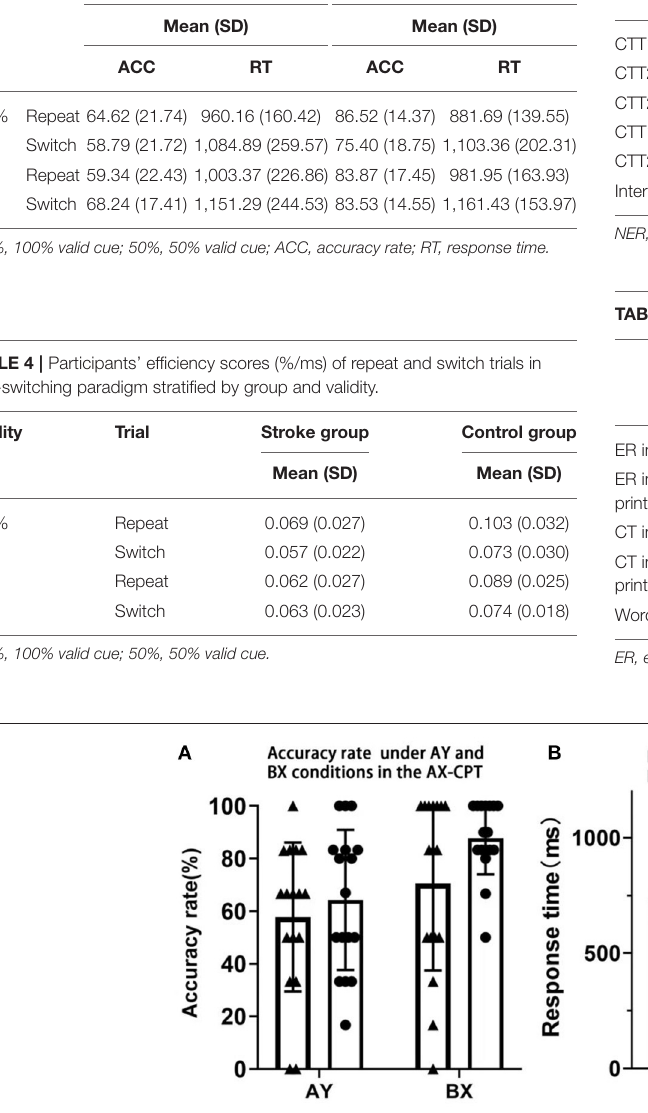
TABLE 3 | Participants’ accuracy rates (%) and response times (ms) of repeat and switch trials in task-switching paradigm stratified by group and validity. validityTrial